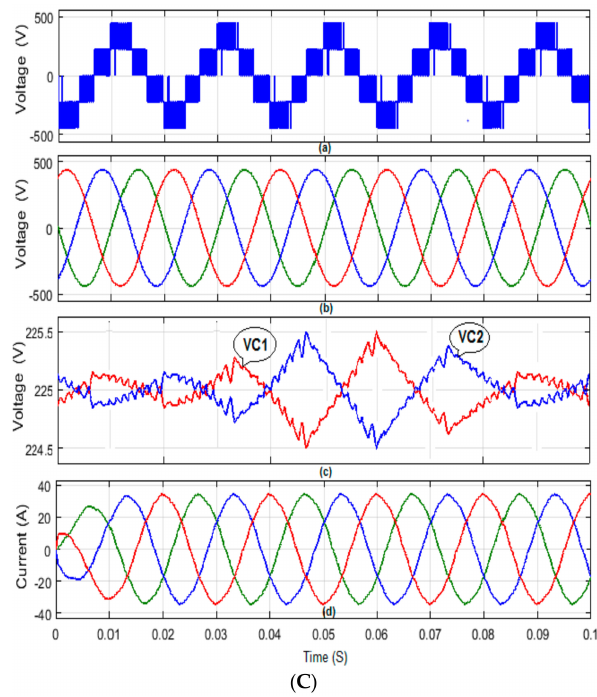
Figure 11. ( A ) 3-leg 3-level NPC inverter with 3D-SVM ( B ) 4-leg 3-level NPC inverter with 2D-SVM ( C ) 4-leg 3-level NPC inverter with effectual 3D-SVM, where ( a ) 3-level stepped inverter output voltage; ( b ) inverter output voltage with split inductor; ( c ) capacitor voltage balancing; and ( d ) inverter output current with split inductor.